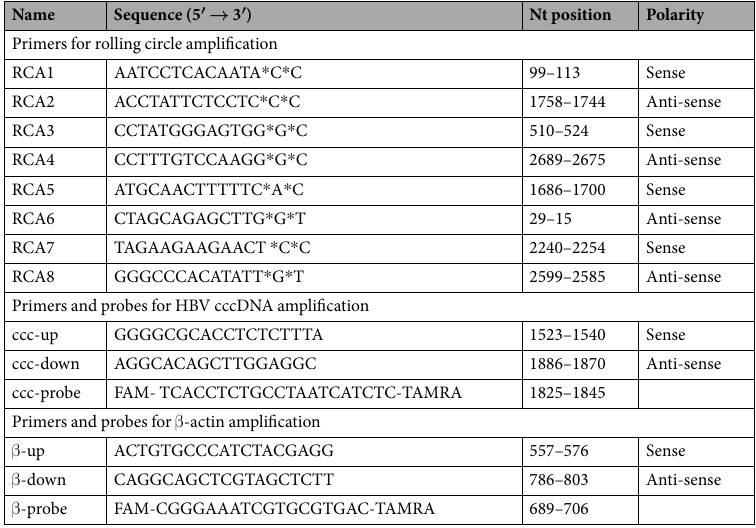
Table 1. Primers and probes used for HBV cccDNA amplification and detection. Note: * Indicates phosphorothioate modifications.